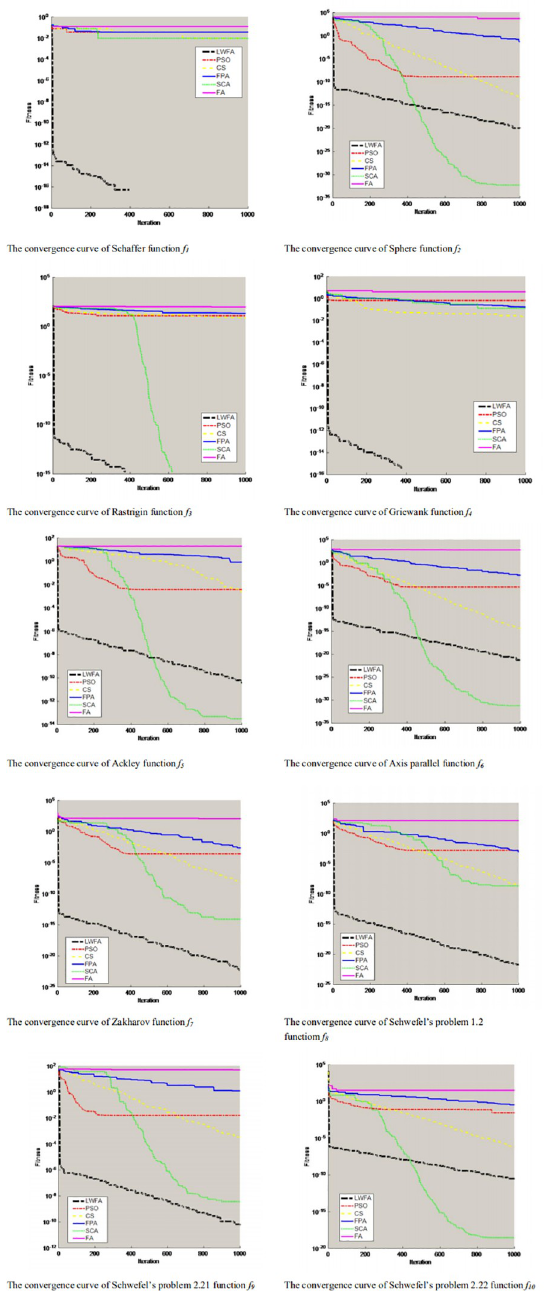
Fig 9. Convergence curve of functions f 1 -f 10 in D =